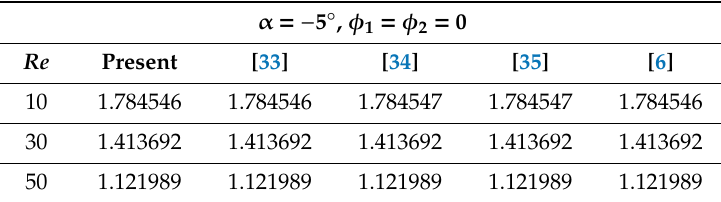
Table 3. Comparison for − F” (0) in narrowing case.